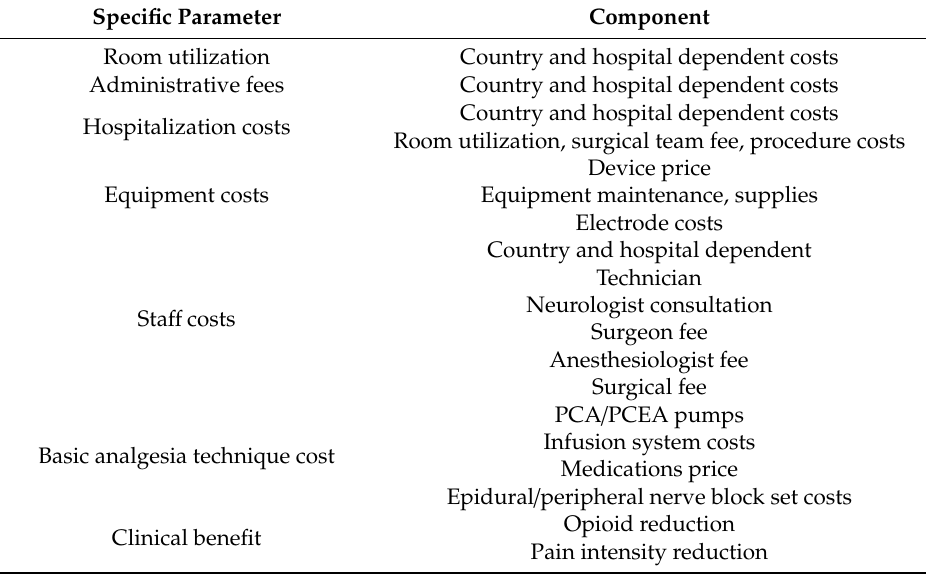
Table4. The”impactinventory”tablefortranscranialdirectcurrent(tDCS)stimulationcost-e ff ectiveness analysis for acute postoperative pain management. The concept of “impact inventory” was suggested by Neumann et al. [11], and the necessary information was retrieved from Zaghi et al. [8] and (Sauvaget et al., 2019)